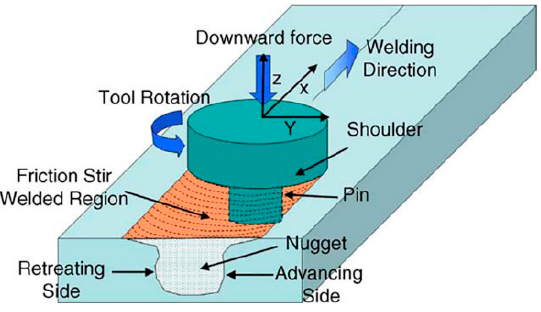
Figure 2. The process of FSP